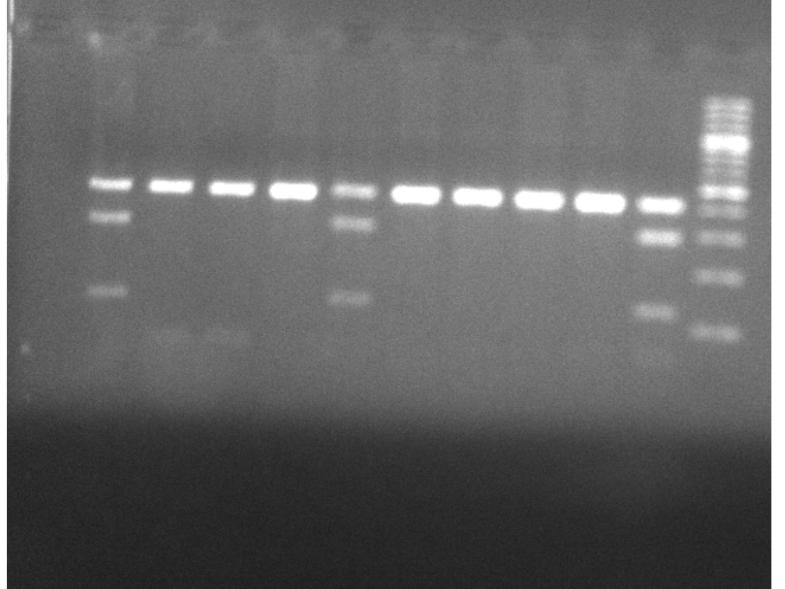
Figure 1. Heterozygous G/A samples are represented in lanes 2, 6 and 11, in which the TNF- α promoter gene was partially cut with the MspI , resulting in 3 DNA fragments of 440, 300 and 140 bp, respectively. Homozygous A/A samples are represented by lanes 3–5 and 7–10 in which an uncut 440 bp fragment is observed. Lane 1 is a negative control and Lane 12, the DNA Ladder, is 100 bp.